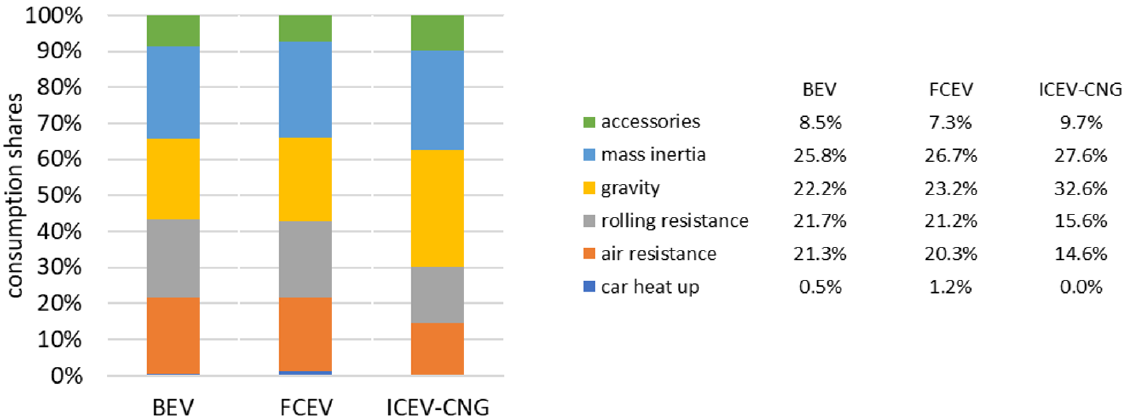
Figure 18. Consumption shares of the investigated drive technologies in 2030 (large passenger vehicle, WLTP cycle, transition season, and hilly terrain).